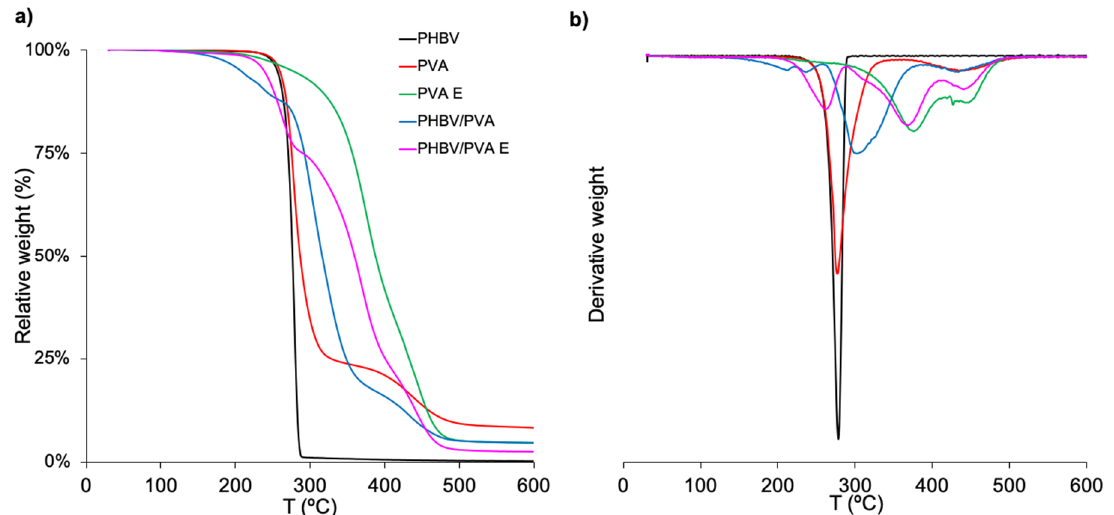
Figure 8. Thermogravimetry results of neat PHBV and PVA, PVA E, 30/70 PHBV/PVA blend and semi-IPN PHBV/PVA E. ( a ) Relative weight loss and ( b ) first derivative of the weight loss as a function of temperature (DTG).